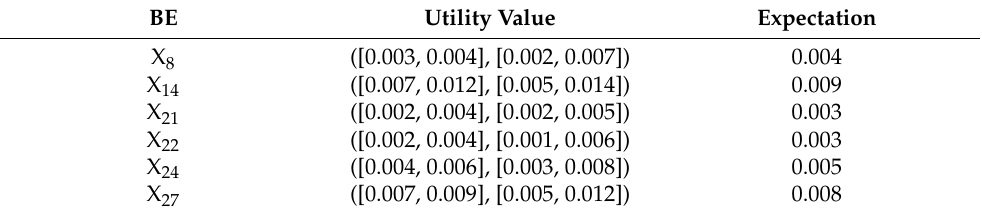
Table 13. The subjective occurrence.